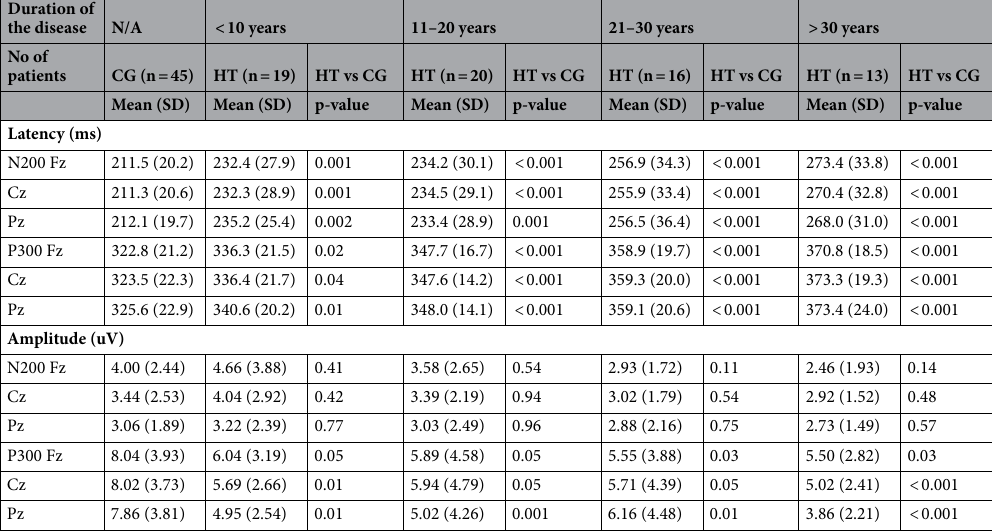
Table 4. Mean values and standard deviations (SD) of N200 and P300 parameters in HT patients depending on the duration of the disease. CG control group, HT Hashimoto’s thyroiditis, SD standard deviation, Fz frontal region, Cz central region, Pz parietal region.